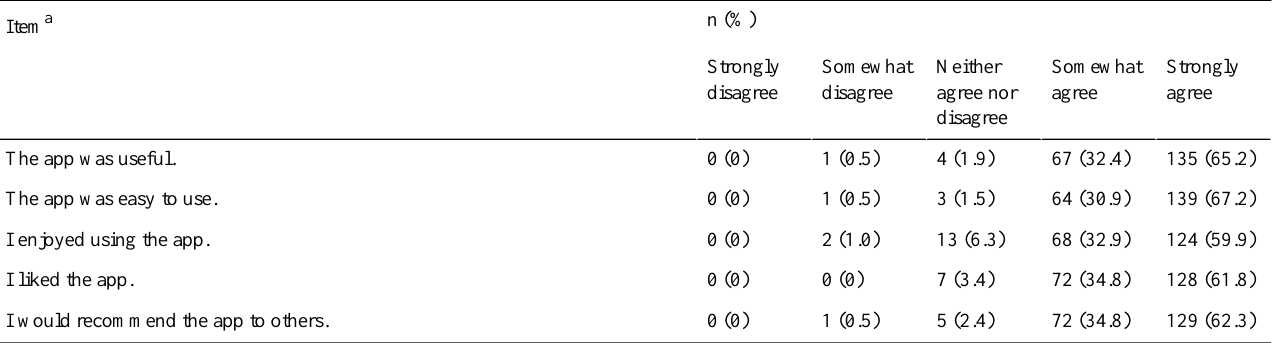
Table 3. Responses to likeability and engagement items (N=207). A composite engagement variable was computed by summing these variables, Cronbach alpha=.890.